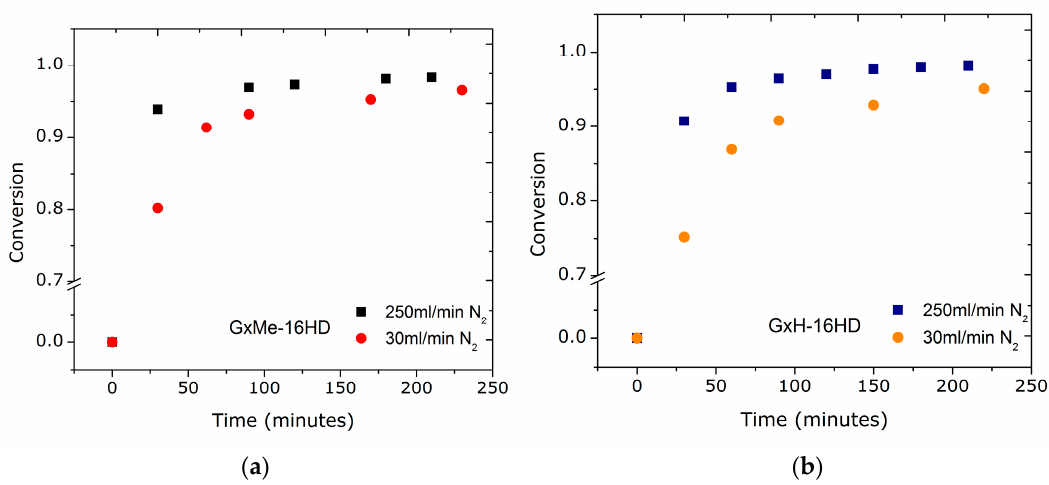
Figure 2. Conversion plots for the transesterification reactions of GxMe and GxH with 1,6-hexanediol when using a 30 mL/min ( a ), respectively, a 250 mL/min N2 flow-rate ( b